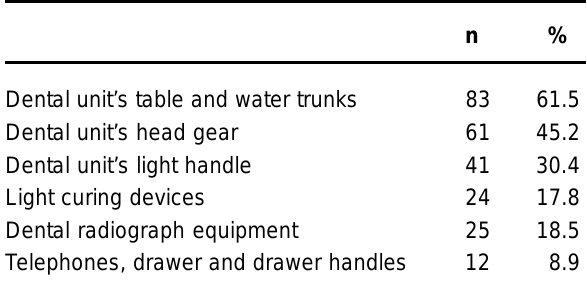
TABLE 5- Preferred barrier protection or cleaning and